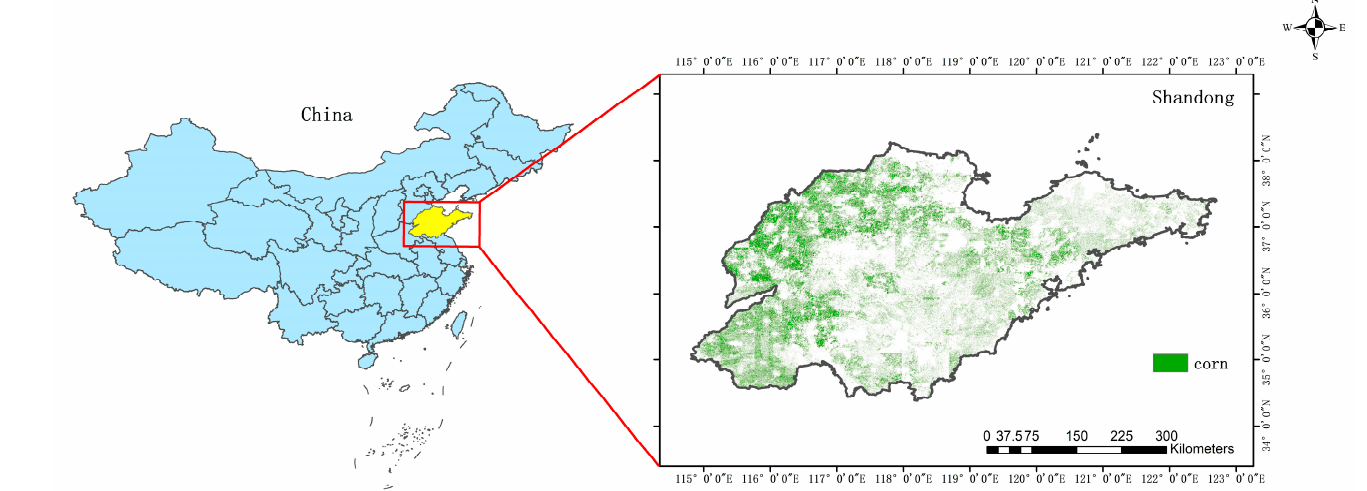
Figure 1. Study area. (Green represents the corn region).